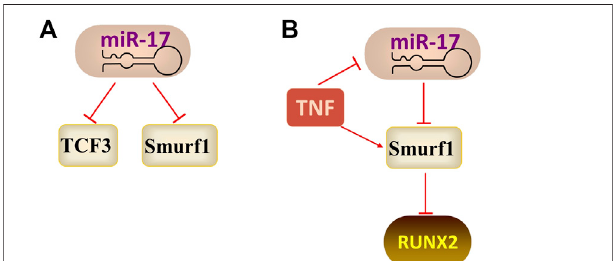
FIGURE 4 | The regulatory mechanism of miR-17. Arrow indicates promotion and T indicates inhibition. (A) miR-17 inhibits osteogenic differentiation by targeting TCF3 or Smurf1 when under normal condition. (B) miR-17 promotes osteogenic differentiation by binding to Smurf1 when under the TNF- α -induced in fl ammatory